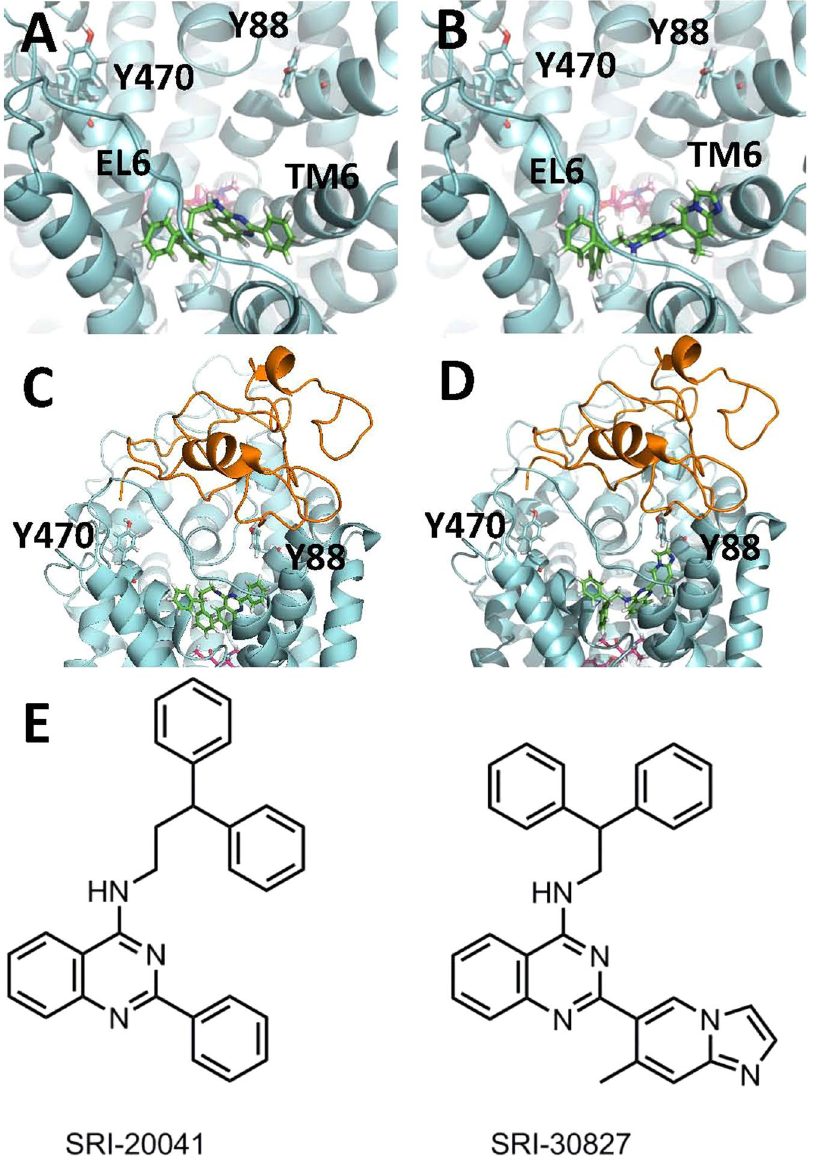
Figure 1. Molecular modeling of binding sites of SRI-20041 and SRI-30827 on DAT. ( A ) The cartoon presentation of the homology model of hDAT 66 (based on the crystal structure of dDAT, PDB ID: 4M48) with SRI-20041 docked to allosteric binding site on the extracellular vestibule. Key residues Tyr470 and Tyr88 are shown in stick style. SRI-20041 and cocaine are shown in green-colored and red-colored solid-sticks, respectively. ( B ) The cartoon presentation of the homology model of hDAT with SRI-30827 docked to the allosteric binding site on the extracellular vestibule. SRI-30827 and cocaine are shown in green-colored and red-colored solid-sticks, respectively; ( C ) and ( D ) SRI-20041 and SRI-30827 were docked to the Tat-hDAT model 66 , respectively. Tat protein is shown in orange-colored cartoon ( E ) structure of the two allosteric ligands, SRI-20041 and